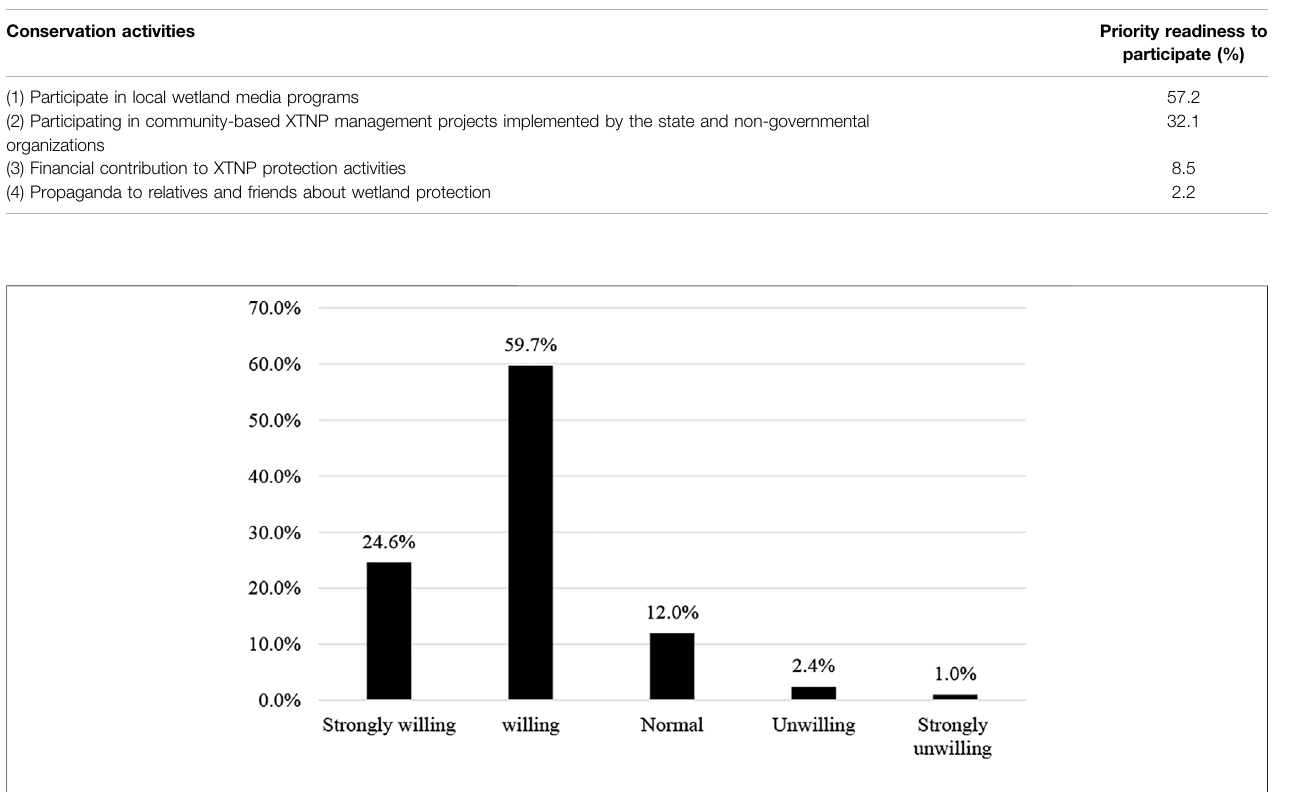
FIGURE 6 | Willingness to sacri fi ce income to protect wetlands for future generations.